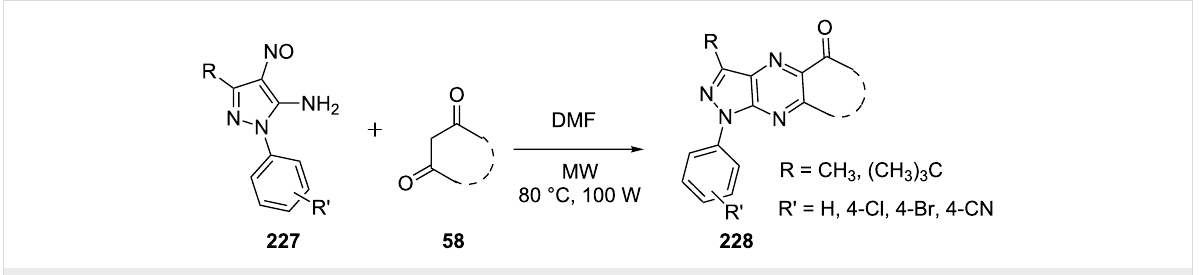
Scheme 62: Microwave-assisted synthesis of pyrazolo[3,4- b ]pyrazines.